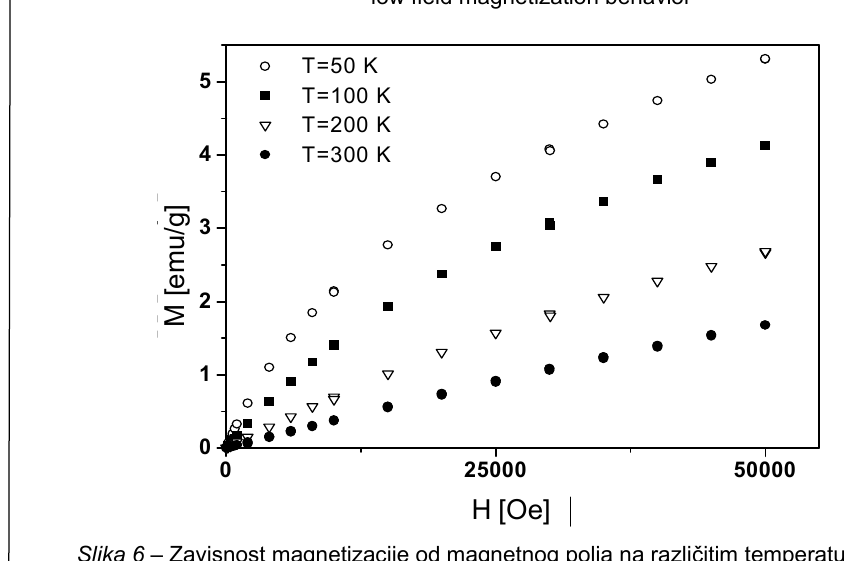
Figure 6 – Magnetization of α -Fe 2 O 3 nanoparticles at several temperatures expressed as a function of the applied field